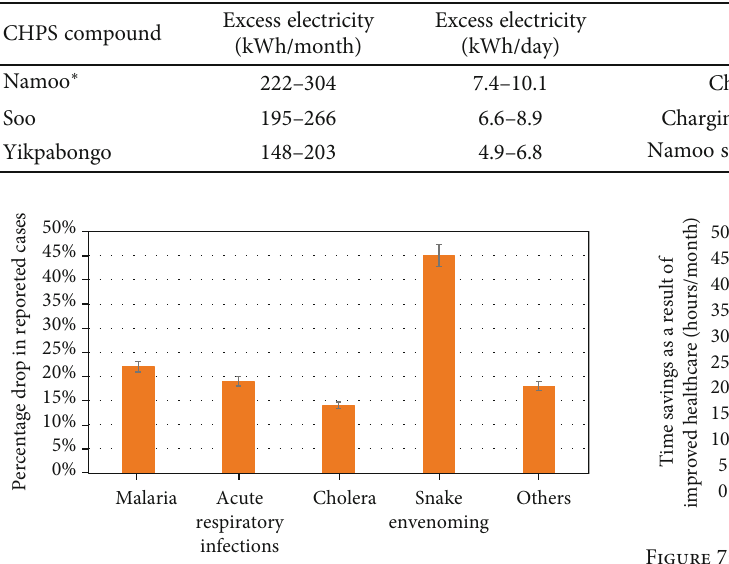
Figure 6: Percentage drop in reported cases after access to electricity at the CHPS.